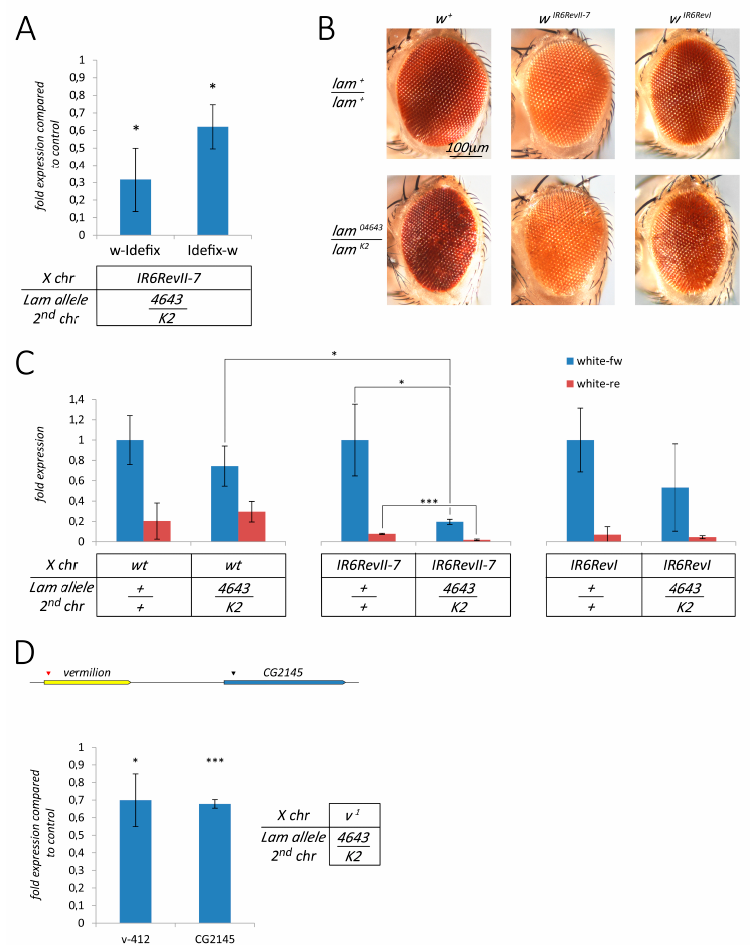
Figure 5. Silencing of the genes located in the neighborhood of silenced euchromatic retrotransposons in Lam mutant flies. ( A ) qRT-PCR analysis of the regions containing the boundaries between Idefix and the white untranscribed regions of w IR6RevII7 ; Lam 04643 / K2 compared to w IR6RevII7 ; Lam + . Data are mean values from three independent experiments, and error bars indicate SD (* P < 0.05). ( B ) Representative bright-field microscope images of adult eyes of wild type, w IR6RevII7 , and w IR6RevI flies with and without lam loss-of-function mutant allelic combination. ( C ) qRT-PCR analysis of white expression in RNAs isolated from female head tissues. Blue histograms represent sense expression, while red histograms represent anti-sense expression. white expression in each genetic background is referred to the sense expression of its specific control. Data are mean values from three independent experiments, and error bars indicate SD (* P < 0.05; *** P < 0.001). ( D ) Upper part: schematic representation of the genomic region containing the vermilion and CG2145 genes. Black arrowhead indicates the 412 insertion point where v-412 primers were designed, while red arrowhead indicates the region where CG2145 primers were designed (see Table S1). Lower part: qRT-PCR analysis in RNAs isolated from female head tissues in Lam 04643 / K2 mutants compared to the Lam +/+ in the v 1 mutant background. Data are mean values from three independent experiments, and error bars indicate SD (* P < 0.05; *** P <